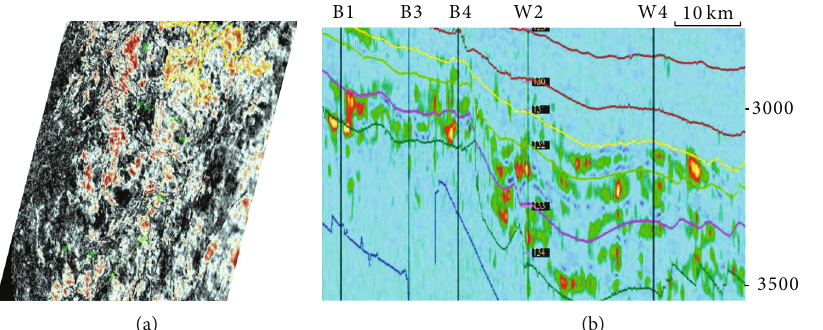
Figure 15: Coincidence veri fi cation between prediction of gas-bearing traps and high-frequency gas layer in T32 period: (a) distribution of gas trap in plane; (b) longitudinal distribution of high-frequency gas-bearing